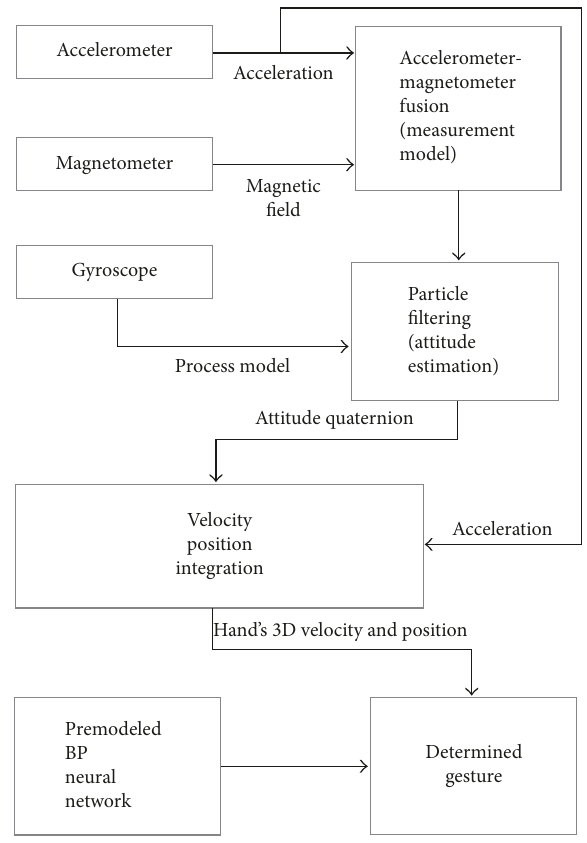
Figure 1: Basic structure of the